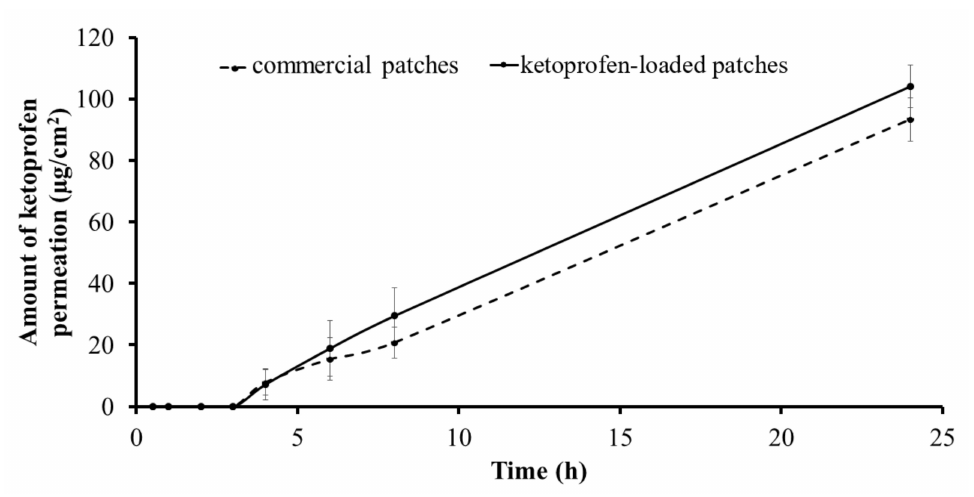
Figure 7. The skin permeation profiles and the skin permeation parameters of the drug-loaded patches and the commercial patches. Table 4. Stability study of the ketoprofen-loaded PVPAA/PMVEMA